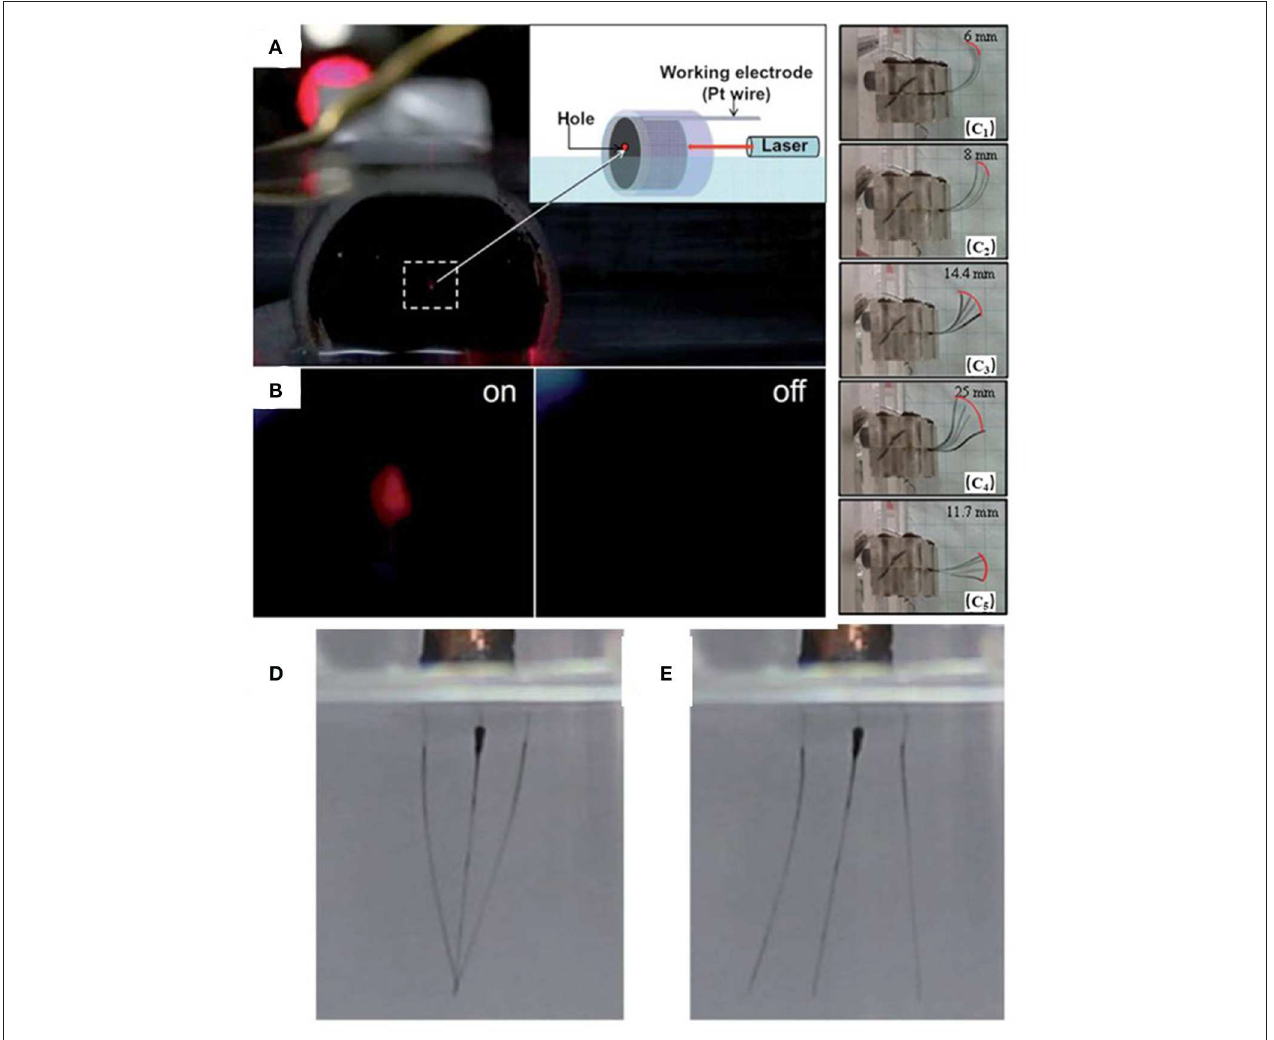
FIGURE 6 | (A) Photograph of a designed device in which G–PPy was filled into a plastic pipeline with a microsized hole in the center of G–PPy. The G–PPy was partially immersed in 1M NaClO4 solution and the hole was exposed to a laser beam for visibility. A Pt wire in contact with the sample was used as working electrode. (B) The open (on) and closed (off) state of the hole under the applied potential of + 0.8V and − 0.8V, respectively (reproduced from Liu et al., 2012 with permission from The Royal Society of Chemistry). The corresponding overlaid digital images captured at the starting point and the end point for the actuators (C 1 ) IP -PPy, (C 2 ) IP-PPy/rGO-1, (C 3 ) IP-PPy/rGO-2, (C 4 ) IP-PPy/rGO-3, and (C 5 ) IP-PPy/rGO-4 in response to (A,D) . (C) Voltage of 6V in amplitude (reproduced from Rasouli et al., 2018 with permission from The Royal Society of Chemistry). (D,E) Snapshots of the tri-armed tweezers driven by an applied electric potential of + 0.8V and − 0.8V, respectively. (Reproduced with permission. Copyright Wang Y. et al., 2013, Elsevier